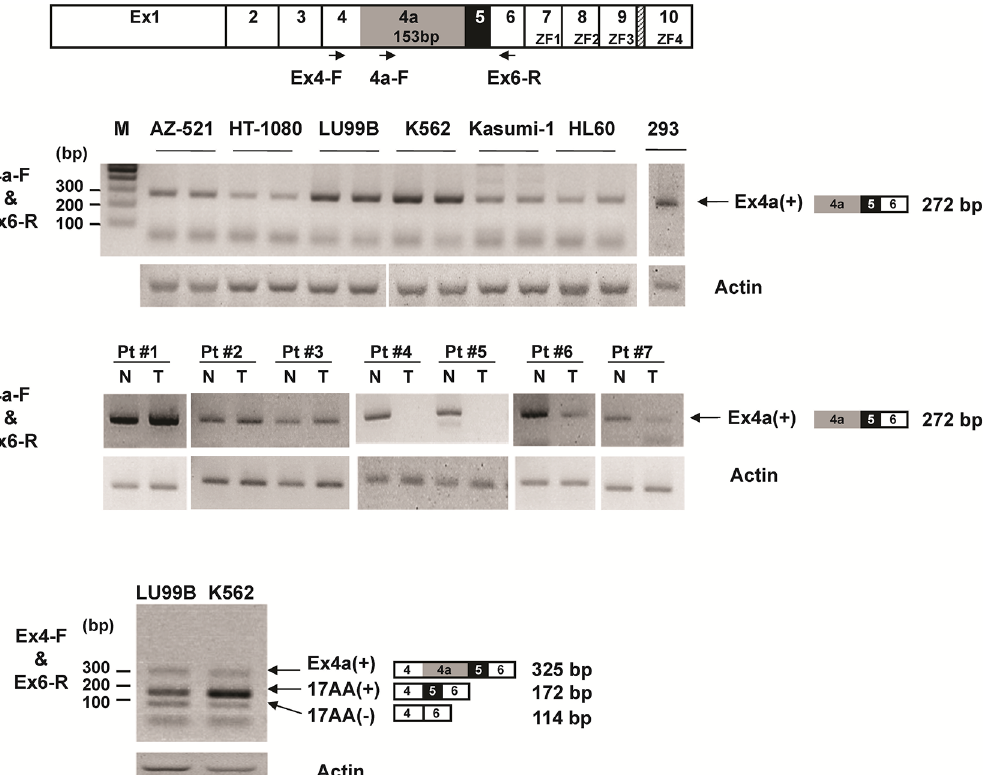
Fig 4. Expression of Ex4a(+)WT1 isoform in human cancer cells. ( A ) Schematic representation of the WT1 exons and localization of the primers used for semi-quantitative RT-PCR (arrows) are shown. ( B ) Ex4a(+)WT1 mRNA expression was determined by RT – PCR using 4a-F and Ex6-R primer pair that amplifies only Ex4a(+)WT1 isoform in six different WT1-expressing cancer cells (AZ-521, HT-1080, LU99B, K562, Kasumi-1 and HL60) and one WT1-expressiong normal kidney cells 293. ( C ) Ex4a(+)WT1 mRNA expression in the paired samples of tumor (T) and normal tissues (N) of seven NSCLC was determined by RT-PCR as indicated in (B). ( D ) The ratio of Ex4a(+)WT1 to 17AA(+)WT1 isoforms was determined by RT – PCR using Ex4-F and Ex6-R primer pair that amplifies both Ex4a(+)WT1 and major WT1 isoforms in two different WT1-expressing cancer cells (LU99B and K562). (B-D) Actin is used as an internal control. Results are representative of three independent